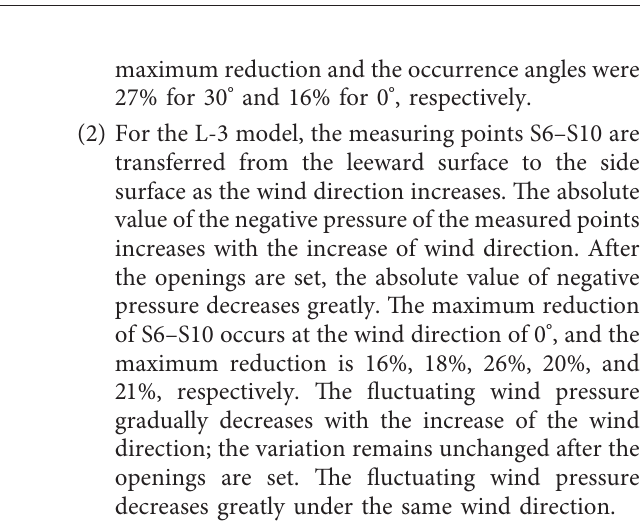
Table 4: Variation of wind speed of monitoring point b Wind direction V